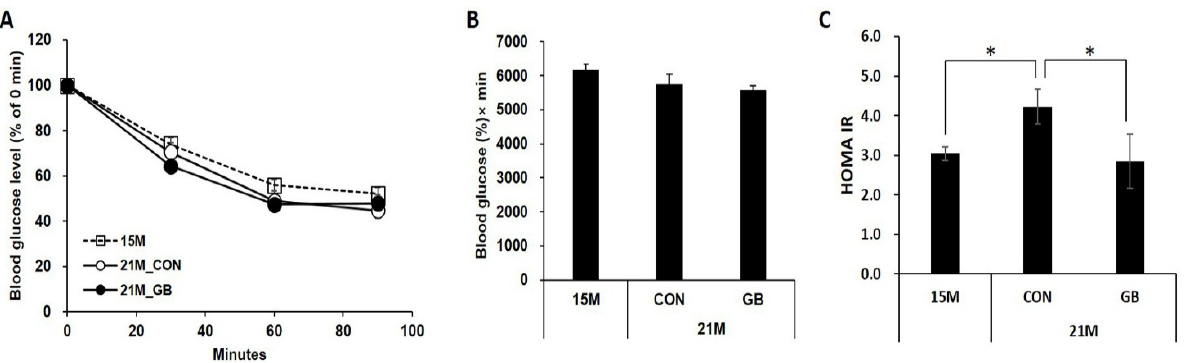
Figure 3. Ginseng berry (GB) extract supplementation improves insulin sensitivity in aged mice. Fifteen-month-old mice were fed a regular diet (CON) or a regular diet supplemented with 0.05% GB extract for 24 weeks. Insulin was administered and ( A ) blood glucose levels and ( B ) the area under the blood glucose curve (AUC) were measured at 21 months of age; ( C ) The insulin resistance scores (HOMA-IR) score was calculated. Values are means ± SE, n = 8 group −1 , * p <